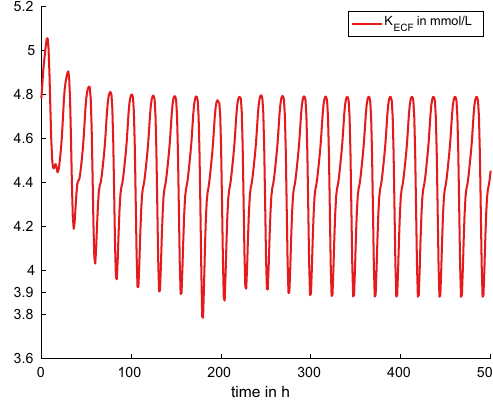
Figure 8. Experiment 7: dexamethasone administration at time t = 176 h (default model setting with p 55 = 1 L/h, i.e. 24 L milk production per